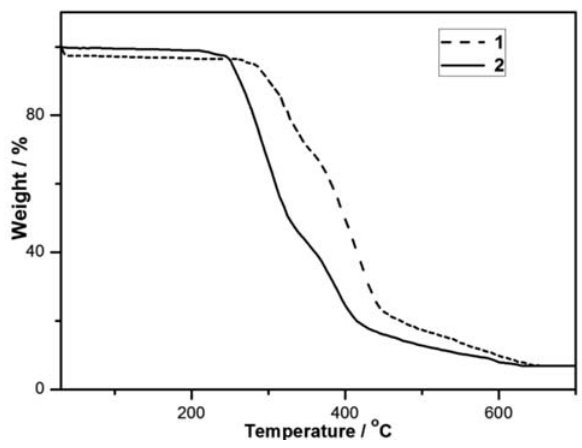
Fig. 4. TG curves of complexes 1 and 2